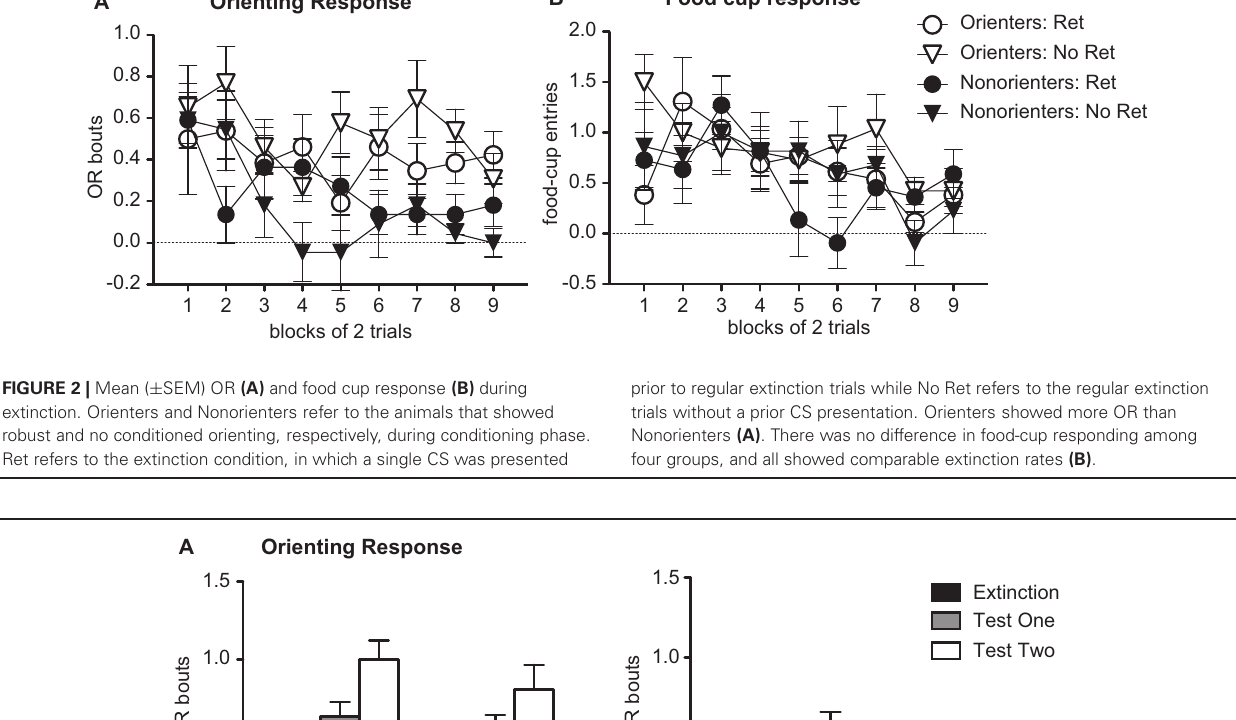
FIGURE 2 | Mean ( ± SEM) OR (A) and food cup response (B) during extinction. Orienters and Nonorienters refer to the animals that showed robust and no conditioned orienting, respectively, during conditioning phase. Ret refers to the extinction condition, in which a single CS was presented